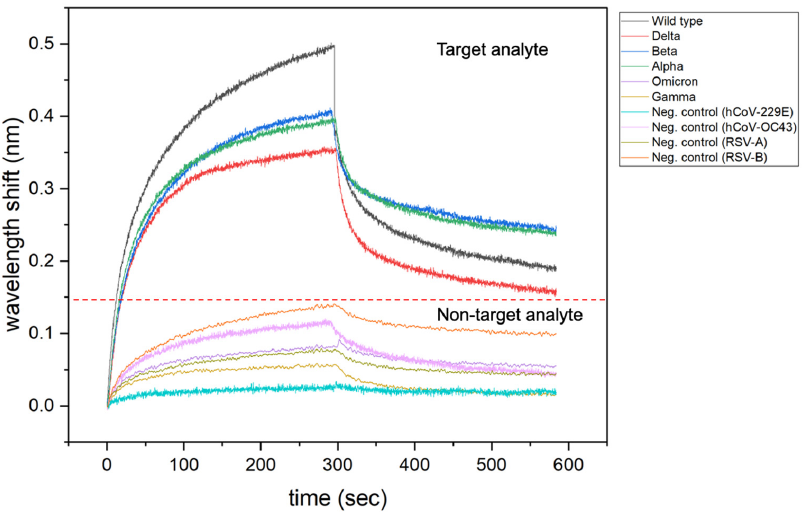
Figure 10. Representative association and dissociation curves for binding assay of ACE2 (ligand) towards target-analyte (SARS-CoV-2) and non-target analytes (Seasonal viruses). towards target-analyte (SARS-CoV-2) and non-target analytes (Seasonal